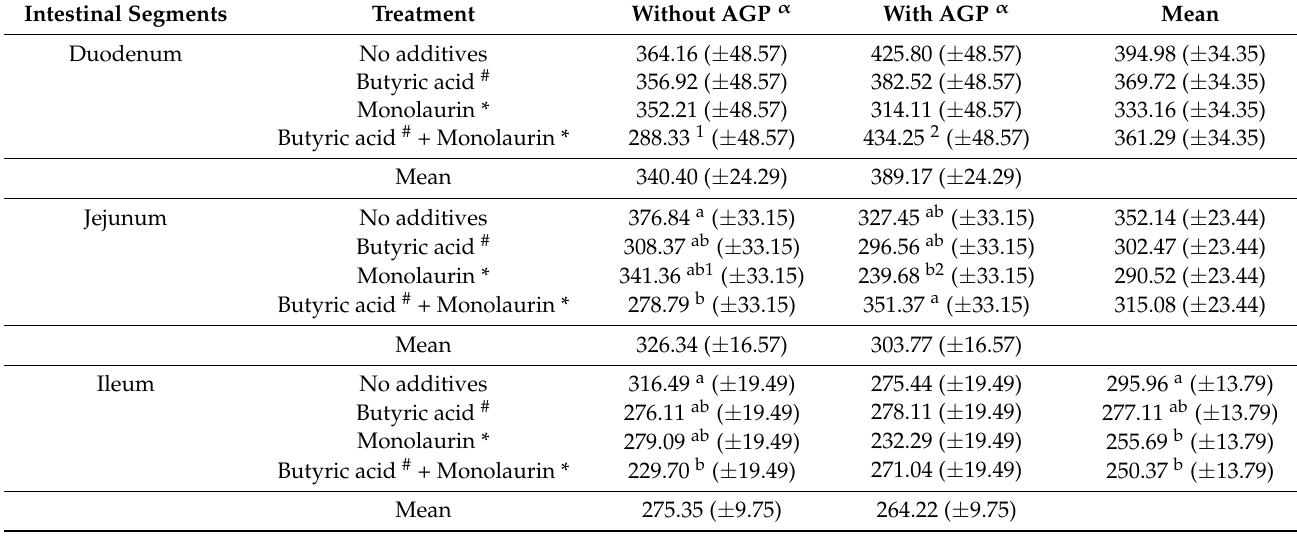
Table 7. The effect of the butyric acid and α -monolaurin, with and without the inclusion of antibiotic growth promoters (AGP), on crypt depth ( µ m) of the duodenum, jejunum and ileum of broilers at 33 days of age ( ± standard error of the mean). Intestinal